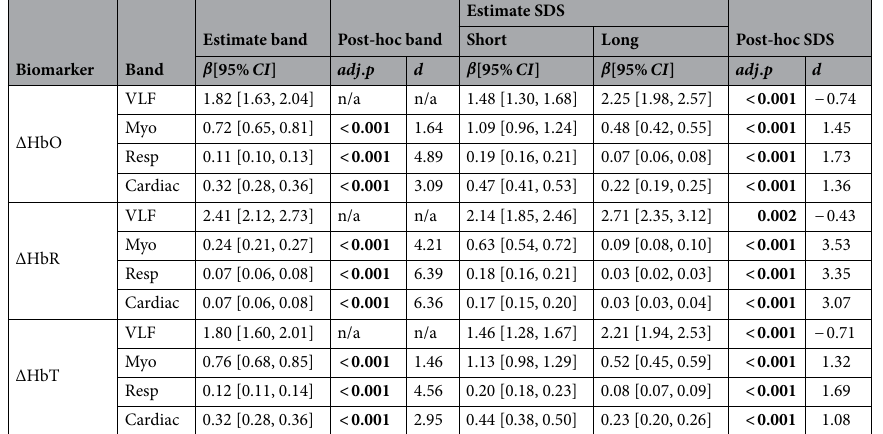
Table 1. Differences in relative energy density ( rel ε ) values between bands and between SDS measurements for each band per biomarker of cognitive stimulus. β Estimate, CI confidence interval; adj . p FDR adjusted p values with bolded values representing significance at α < 0.05, d Cohen’s d. In post-hoc band column, the metrics represent differences between very low frequency (VLF) and other bands (e.g., Myogenic – VLF), where positive d means that the effect was more pronounced in VLF band. Alternatively, in post-hoc SDS column the metrics represent differences between short- and long-SDS measurements, where negative d values mean the effect was more pronounced in long-SDS